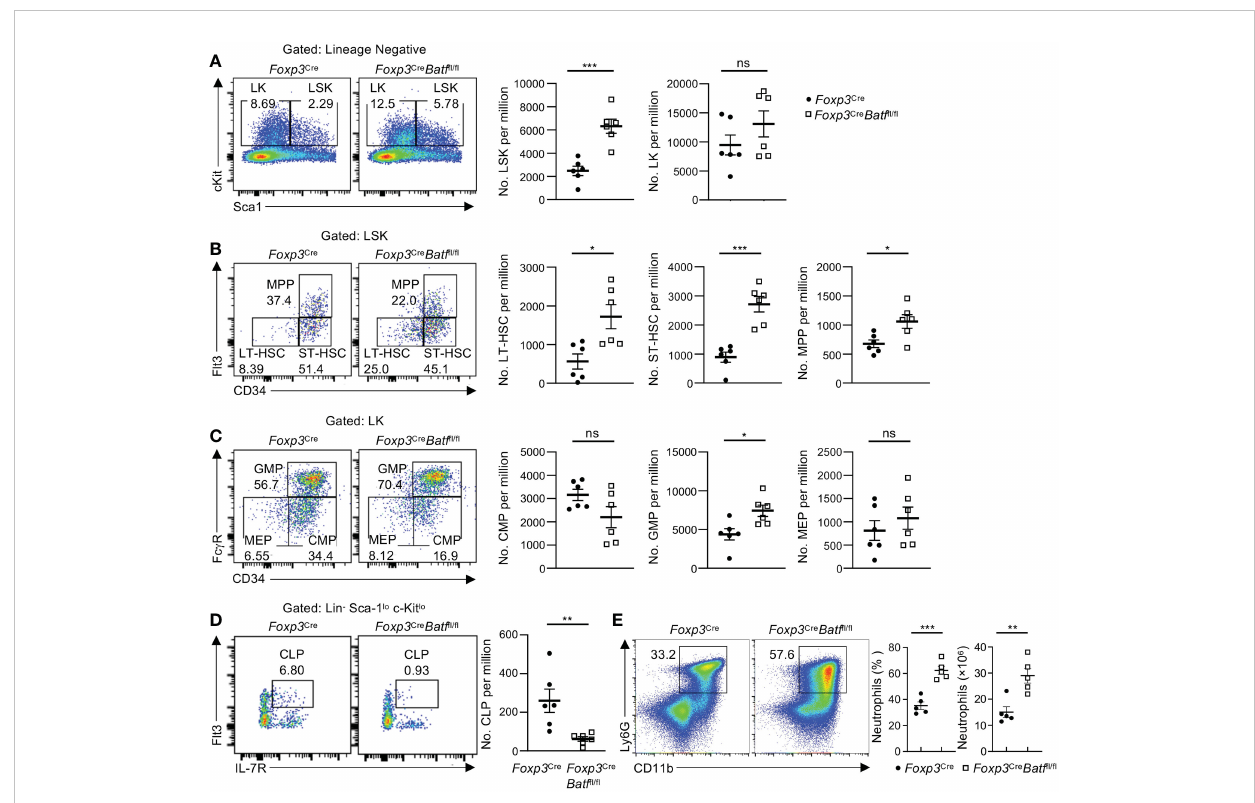
FIGURE 4 BATF de fi ciency in Tregs in fl uences HSC and HPC numbers in the BM. (A) Flow cytometry analysis of the LSK and LK cell population in femoral BM of Foxp3 Cre and Foxp3 Cre Batf fl / fl mice. Numbers of LSK (middle) and LK cells (right) per million ( n = 6 per group). (B) Flow cytometry analysis of the LT-HSC, ST-HSC and MPP cell population in femoral BM of Foxp3 Cre and Foxp3 Cre Batf fl / fl mice. Numbers of LT-HSCs (left), ST-HSCs (middle), and MPPs (right) per million ( n = 6 per group). (C) Flow cytometry analysis of the CMP, GMP and MEP cell population in femoral BM of Foxp3 Cre and Foxp3 Cre Batf fl / fl mice. Numbers of CMPs (left), GMPs (middle) and MEPs (right) per million ( n = 6 per group). (D) Flow cytometry analysis of the CLP population in femoral BM of Foxp3 Cre and Foxp3 Cre Batf fl / fl mice. Right, numbers of CLPs per million ( n = 6 per group). (E) Flow cytometry analysis of neutrophils (CD11b + Ly6G + ) in the BM from Foxp3 Cre and Foxp3 Cre Batf fl / fl mice. Frequencies (middle) and numbers (right) of neutrophils in the BM ( n = 5 per group). Data are representative of at least three independent experiments (A-E) . Data are the mean ± s.e.m. P values are determined by two- tailed Student ’ s t -test (A-E) . * P < 0.05, ** P < 0.01, and *** P < 0.001. ns, not signi fi